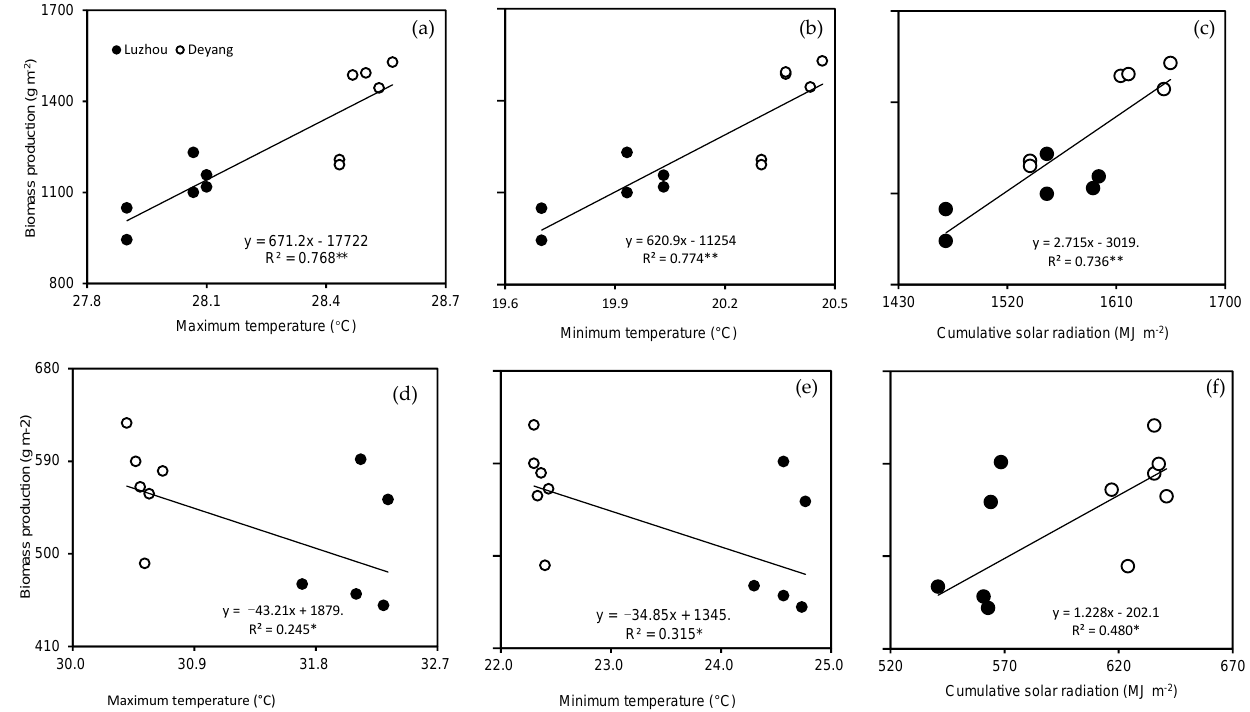
Figure 4. Relationships between biomass production and maximum temperature ( a ), minimum temperature ( b ), and solar radiation ( c ) during the pre-heading periods and between biomass production and maximum temperature ( d ), minimum temperature ( e ), and solar radiation ( f ) during the post-heading periods for six rice cultivars over three years. ‘* ‘and ‘**’ denote significant relationships at the 0.05 and 0.01 probability levels, respectively.